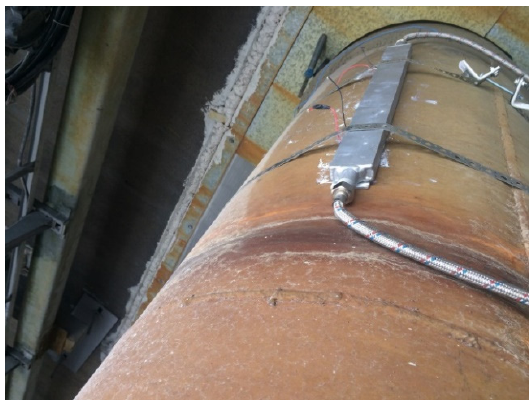
Figure 18. Unit of the thermoelectric converter, installed on the gas duct.